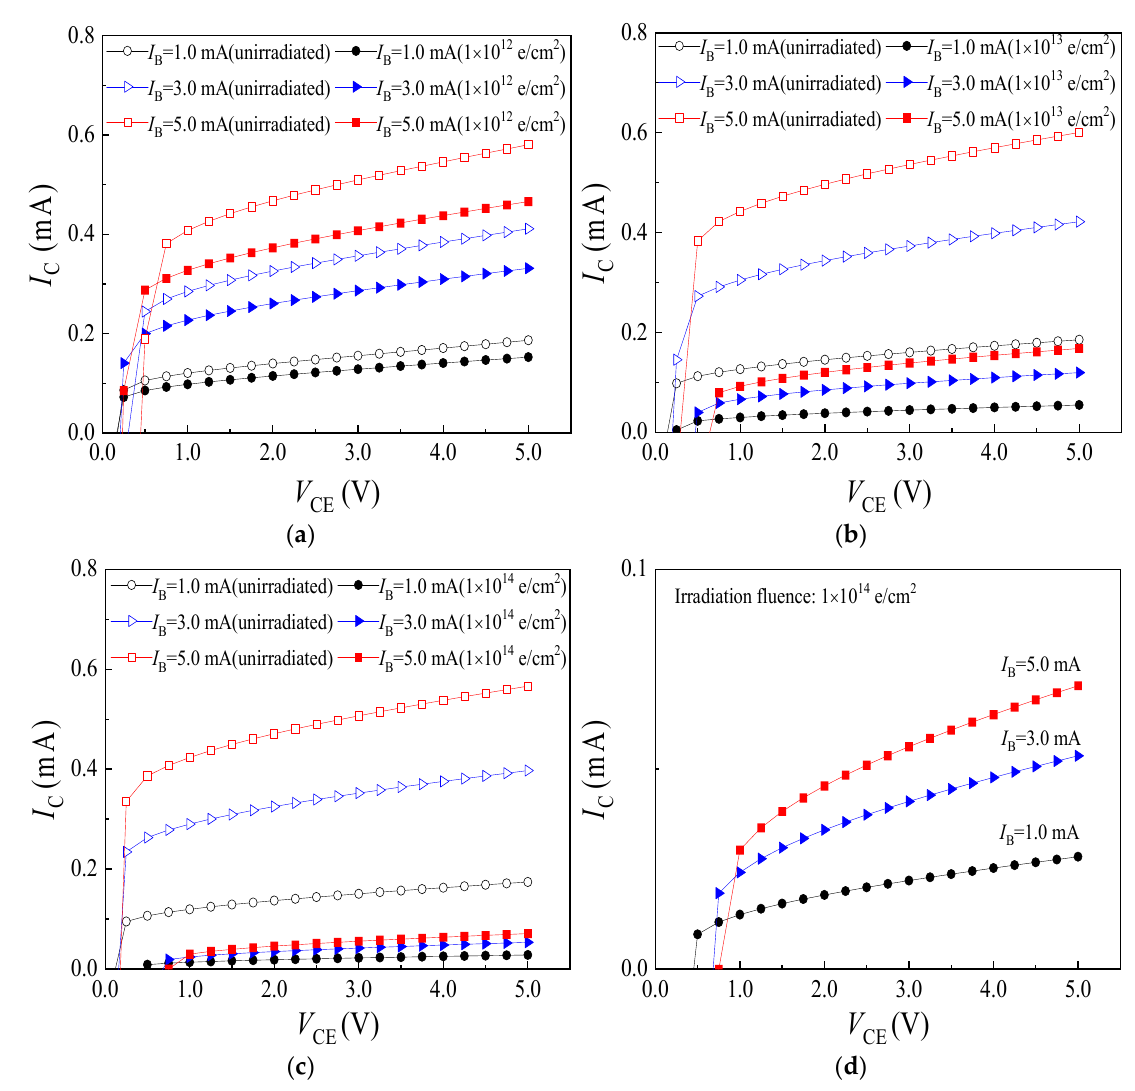
Figure 4. I C - V CE characteristic curves of the SMSTs before and after electron irradiation. ( a ) Sample 1#; ( b ) sample 2#; ( c ) sample 3#; ( d ) highlight for irradiated sample 3#.